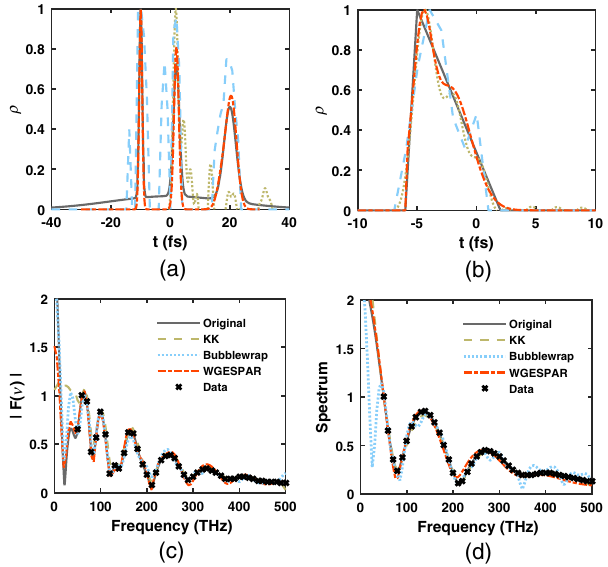
FIG. 4. Reconstructions of special beam current profiles: multibunch spikes superposed on a long bunch (a),(c) and triangular shape (b),(d). The beam current profiles (a),(b) and the spectra (c),(d) are provided for the original current profile (gray line) and the reconstruction result of the WGESPAR algorithm (red dashed line), the KK algorithm (yellow dashed line), and the Bubblewrap algorithm (blue dotted line), respec- tively. The cross spots are sampled from the original